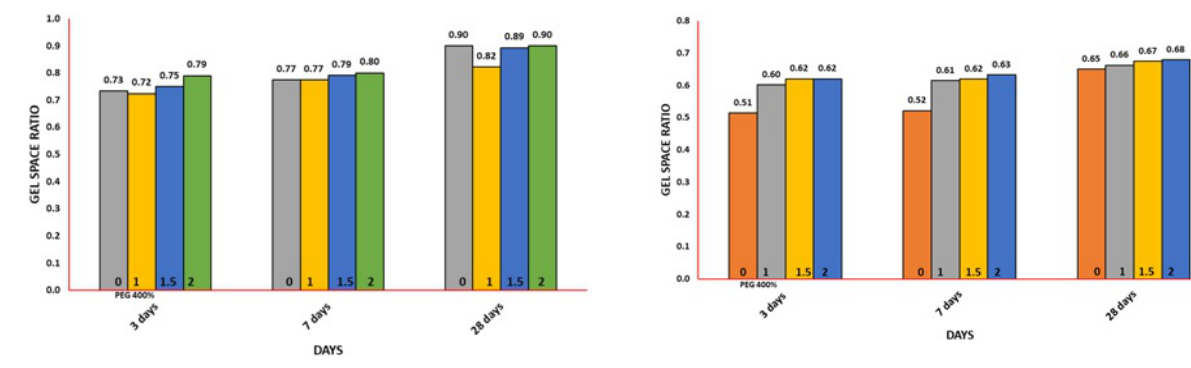
Fig. 11. Gel/Space Ratio at 0.55 Water-Cement